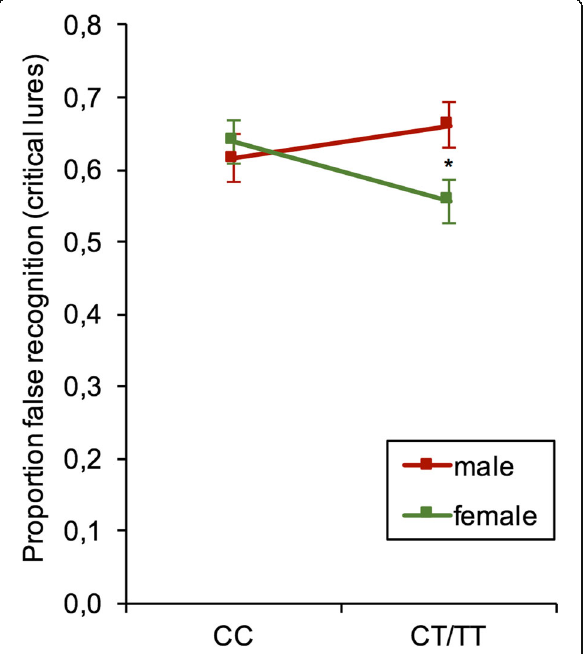
Fig. 1 False recognition rates for critical lures. Female but not male CT/TT carriers show a lower proportion of false recognition rates for critical lures as compared to CC carriers. After controlling for repeated testing, the gender x genotype interaction did not remain significant.